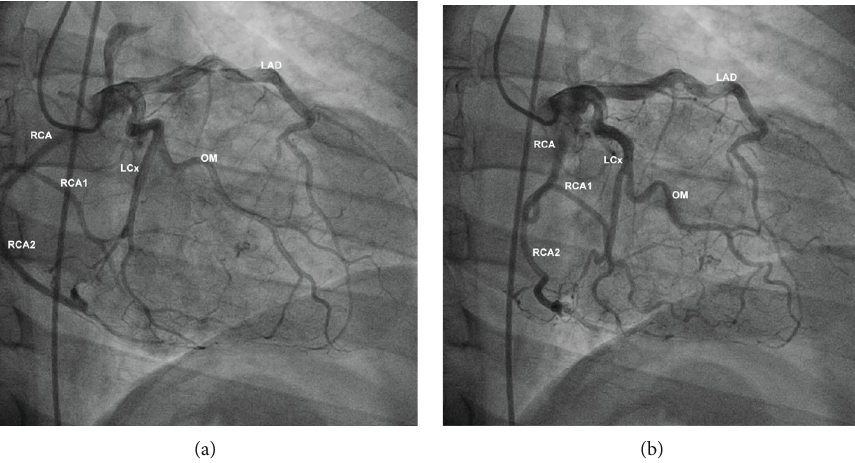
Figure 4: (a, b) Coronary angiography (right anterior oblique projection) revealing the split RCA (marked as RCA1 and RCA2) with an anomalous origin from the left coronary sinus. The RCA and LCA were outlined simultaneously using the JL4 catheter placed at the left coronary sinus. LCx: left circum fl ex artery; OM: obtuse marginal artery; LAD: left anterior descending (artery).